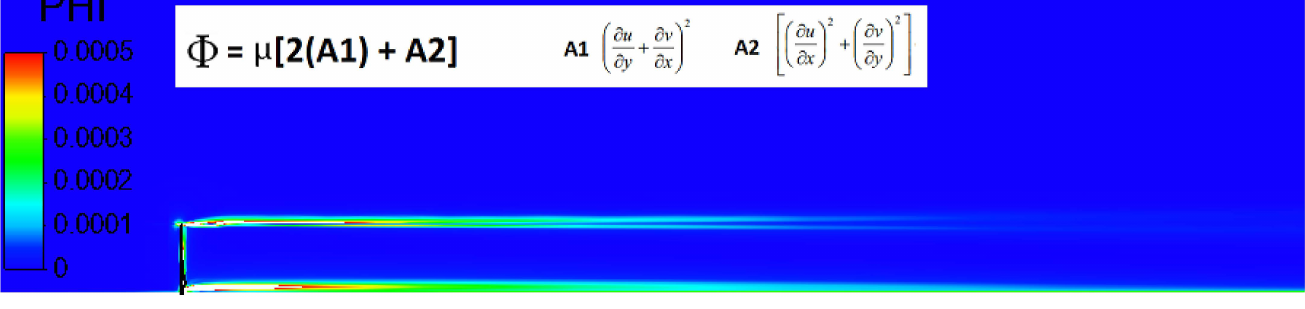
Figure 35. Kinetic energy dissipation downstream of the wind turbine rotor.